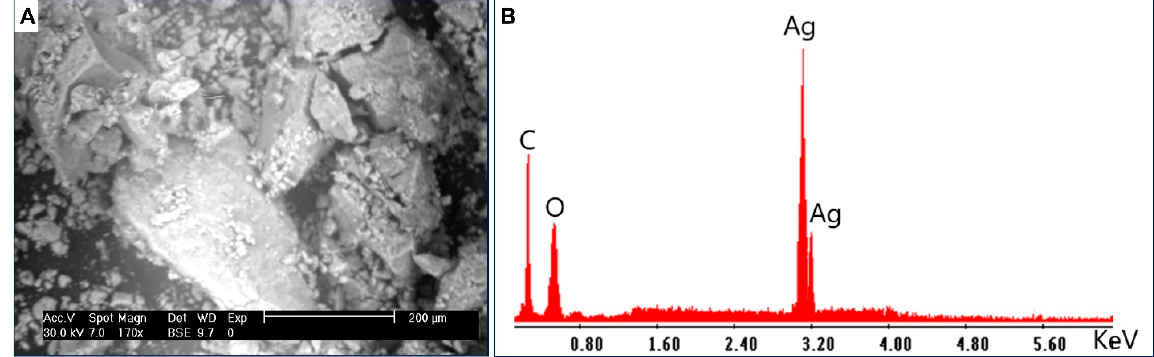
Figure 4. ( A ) is SEM analysis and ( B ) is the EDX chart of fungal-mediated biosynthesis of Ag-NPs.